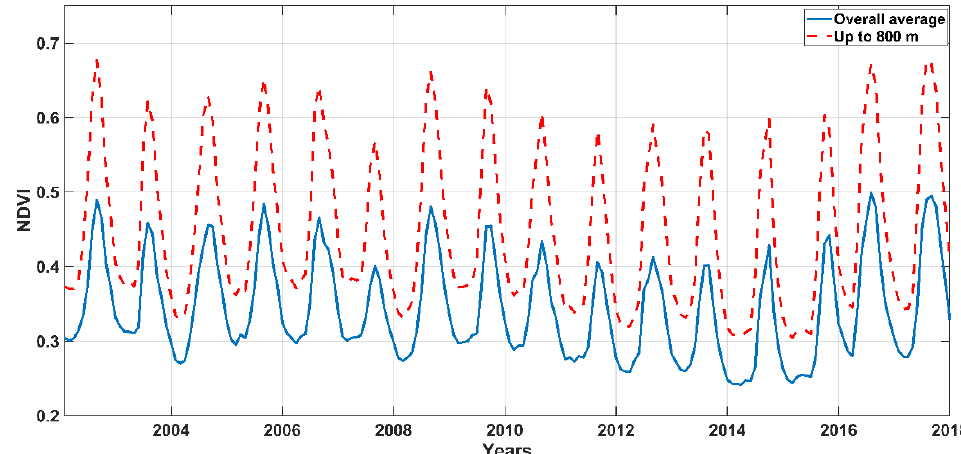
Figure 9. Moderate Resolution Imaging Spectroradiometer (MODIS) Normalized Difference Vegetation Index (NDVI) time series in the watersheds and land up to 800 m from 2002 to 2017.